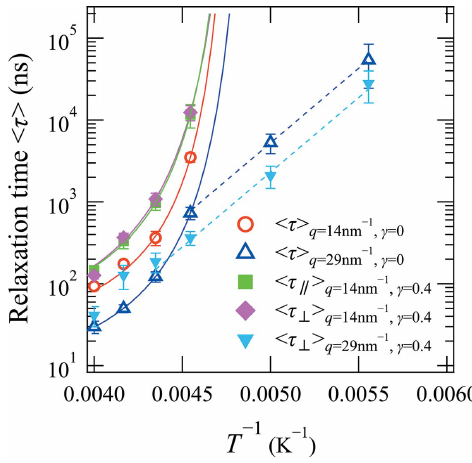
Figure 4 Temperature dependences of the mean relaxation times h (cid:3) i of the crosslinked PB in the unstretched state ( (cid:2) = 0) at q = 14 nm (cid:2) 1 (red circles) and 29 nm (cid:2) 1 (blue open triangles), and under uniaxial deformation ( (cid:2) = 0.4) at q = 14 nm (cid:2) 1 in the directions parallel (green filled squares) and perpendicular (magenta filled diamonds) to elongation. Also shown are the temperature dependences of the mean relaxation times h (cid:3) i of the crosslinked PB at 29 nm (cid:2) 1 in the direction perpendicular (cyan filled down-triangles) to elongation. The solid curves represent fitting of the data to the Vogel–Fulcher–Tammann equation. The dashed lines represent fitting of the data to the Arrhenius equation where the activation energy of the JG (cid:5) -process for the non-crosslinked PB is 35 kJ mol (cid:2) 1